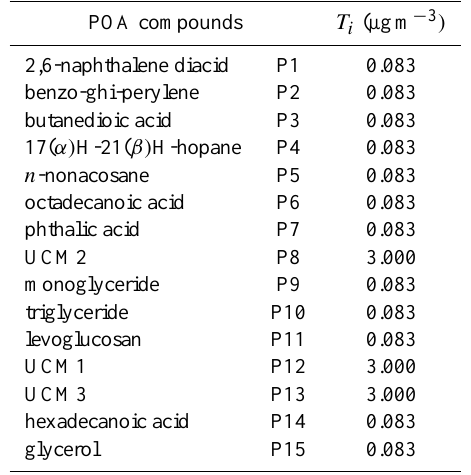
Table 3. Total mass concentration T i values for the hypothetical SOA+POA